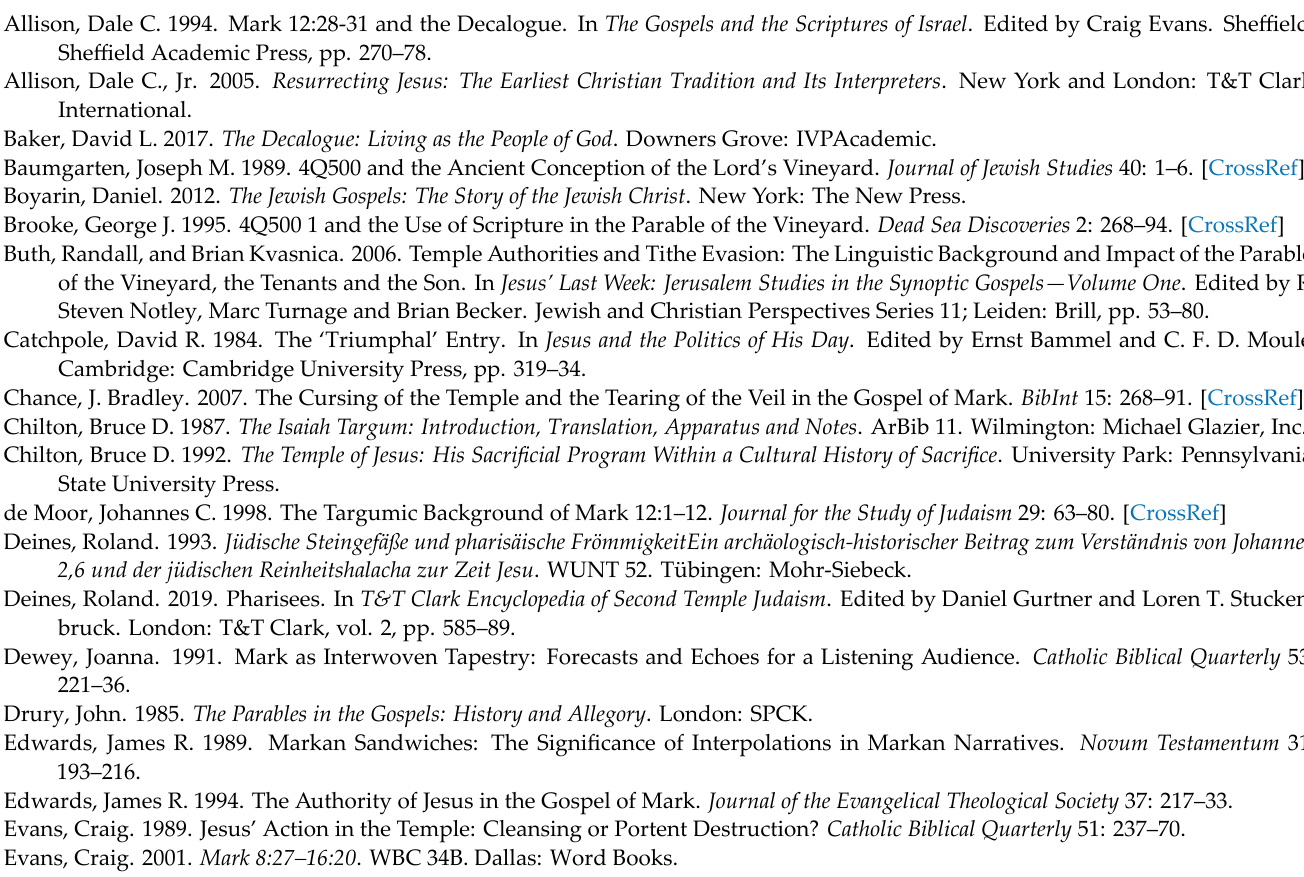
Implicit allusions to the Temple have been found in the correspondence between the tower that the owner built (Mk 12:2) with Targum of Isaiah 5:2, which identifies the tower with the sanctuary (de Moor 1998, pp. 70–71; cf. Evans 2016, pp. 289–302), and the “gate of the holy height” in 4Q500 (Brooke 1995, pp. 270–71), as well as between the fence and wine vat (Mk 12:2) with